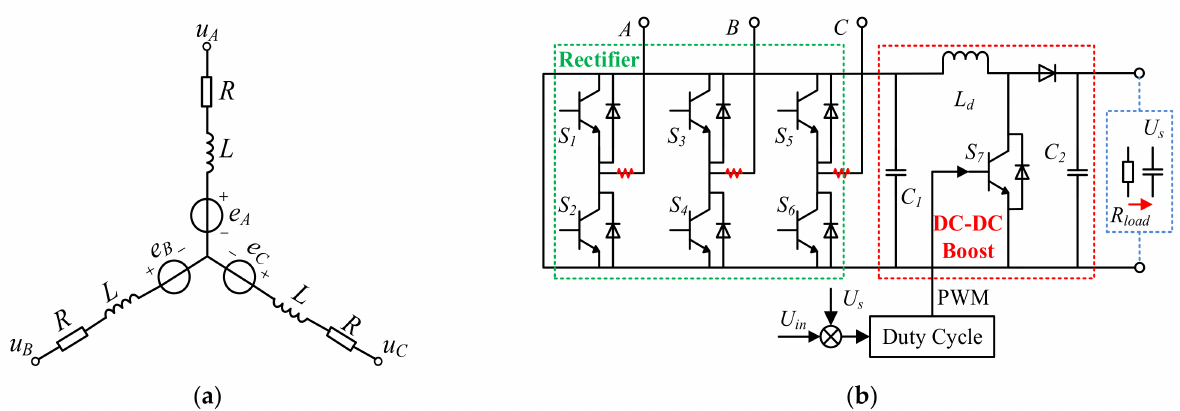
Figure 14. Energy regeneration system: ( a ) Windings circuit of linear motor; ( b ) Energy regenera- tion circuit. Table 3. Parameters of LEMD and LEM-DVA.